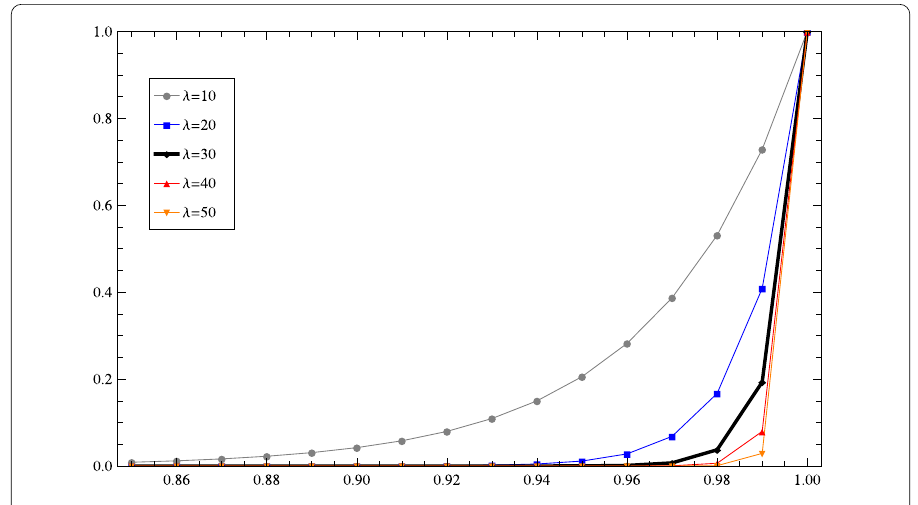
Figure 9 Plot of numerical solutions of approach I for ν 0 = 0, λ = 10, ... ,50 and n = 1 in [0.85,1]